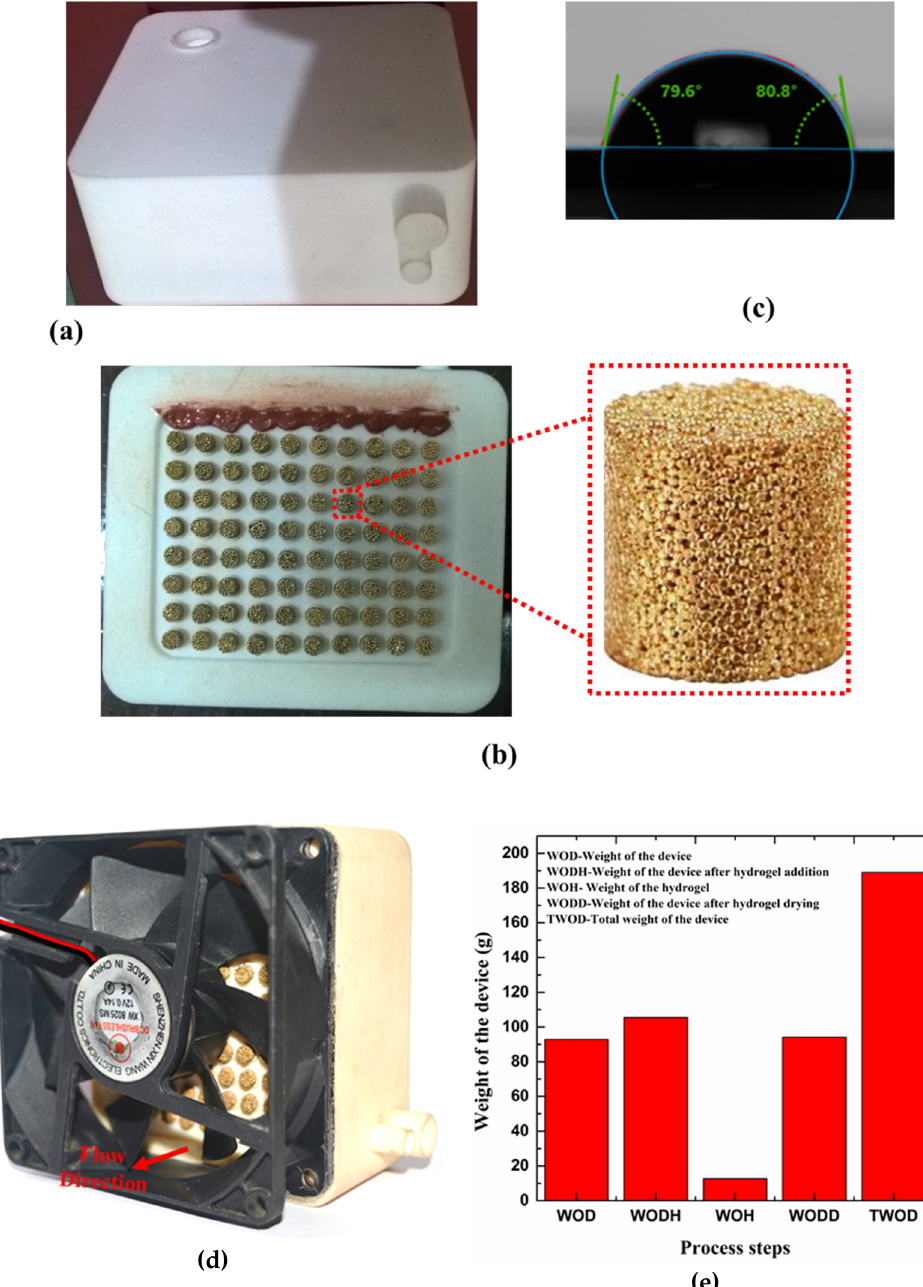
Figure 5. Actual picture of the additively manufactured liver heat and mass transfer. ( a ) Additively manufactured device, front view, ( b ) Additively manufactured device, bottom view, with a sintered bronze disc attached to the array; highlighted section shows the actual bronze sintered disc used in the study, ( c ) contact angle image of the additively manufactured nylon substrate with water, ( d ) complete photograph of the device, showing the airflow direction, and ( e ) weight of the device after different process steps in the